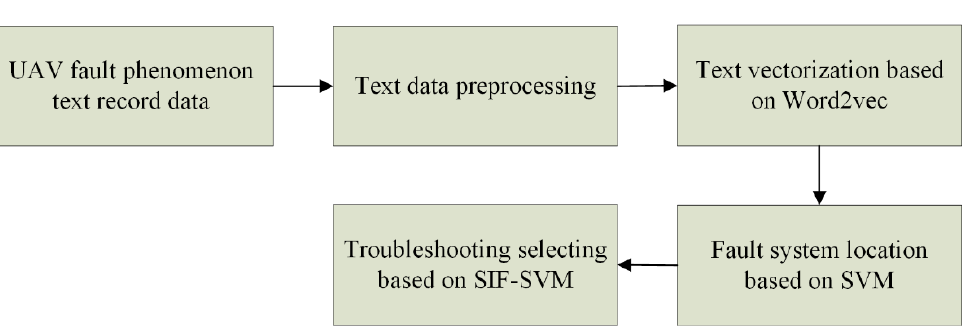
Figure 1. UAV fault phenomenon text record data processing and modeling